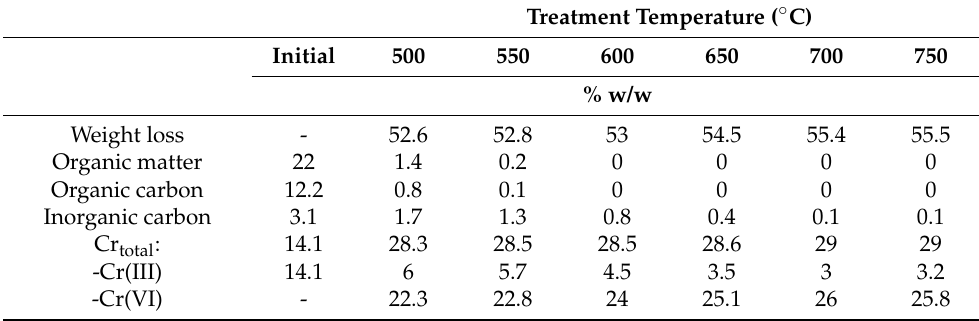
Table 1. Physico-chemical characterization of raw tannery sludge and the corresponding ashes after the application of thermal treatment.